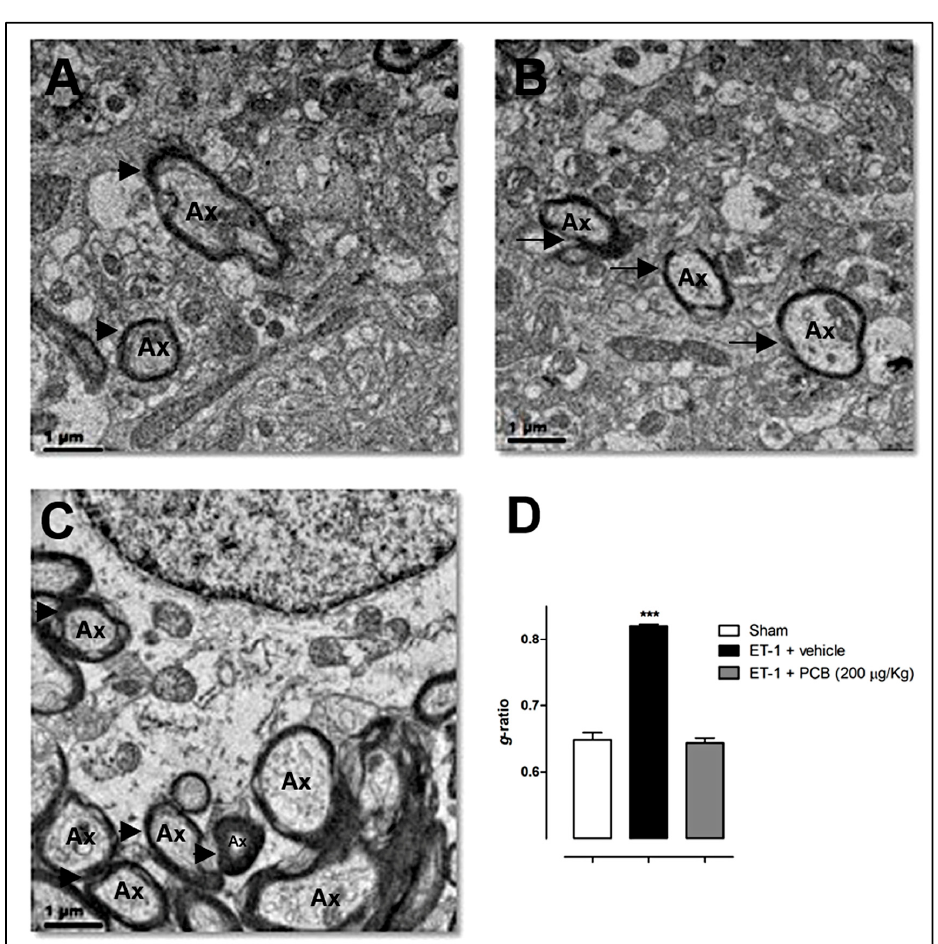
Figure 3. PCB-induced remyelination in a focal transient cerebral ischemia model induced by endothelin-1 (ET-1) in Wistar rats. Panels show representative electron microscopy images of cerebral cortex samples from ( A ) sham; ( B ) ET-1-vehicle treated and ( C ) ET-1-PCB 200 μ g/Kg treated animals. ( D ) g -ratio = [axon diameter/(myelin + axon) diameter] (mean ± S.E.M. *** p < 0.001 vs. control group, ANOVA + Newman-Keuls tests by using GraphPad Prism Software). ET-1 at 600 pmol was stereotaxically injected in the piriform cerebral cortex at the coordinates +0.9 mm (anterior), +5.2 mm (lateral), − 8.3 mm (dorsoventral) respective to bregma, adjacent to the middle cerebral artery. PCB 200 μ g/Kg or the vehicle, were administered i.p. in equal subdoses at 30 min, 1, 3 and 6 h post-surgery ( n = 5 each group). Sham animals received saline instead of ET-1. Brain samples were taken 24 h after the ischemic insult. Arrowheads or arrows indicate normal myelin structure/thickness or myelin damage/loss, respectively. Ax: axon. Bar = 1 μ m.